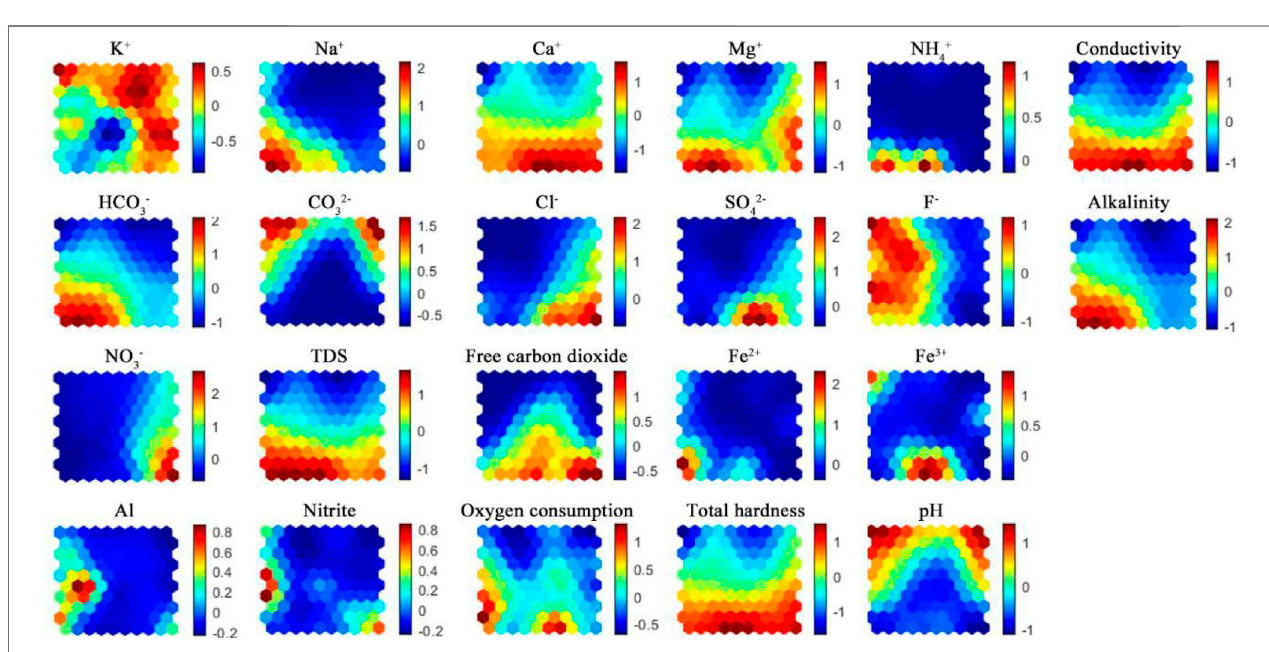
FIGURE 6 | Visualize gradients for each